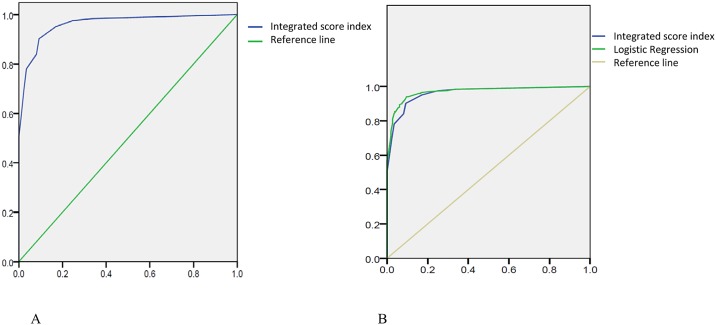
(A) Use of the integrated score index and predicted probability to discriminate any DHF in all the subjects (U.S. grades 1, 2, and 3). Integrated score index AUROC: 0.962 (blue line: integrated score index; green line: reference line). (B) The AUROC of the integrated score index used to predict any diastolic dysfunction (U.S. grades 1, 2, and 3) was 0.962, and the AUROC of the method suggested by the logistic regression was 0.970 (blue line: integrated score index; green line: logistic regression; yellow line: reference line).